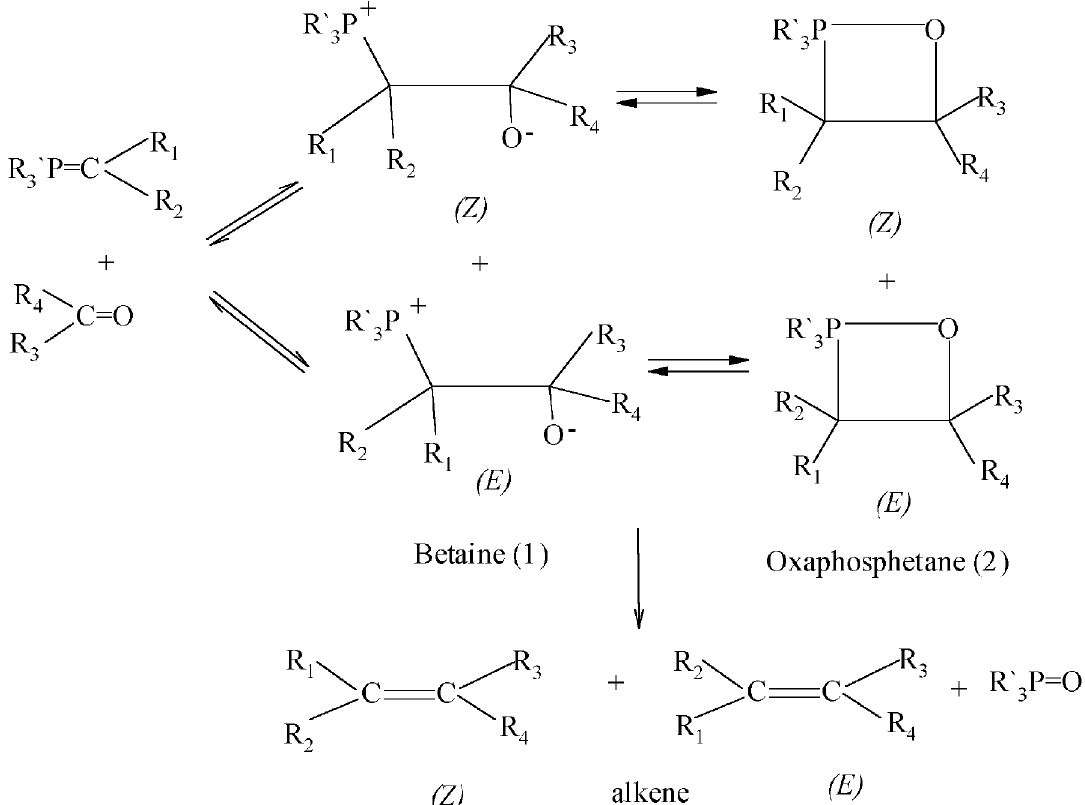
Scheme 2 The mechanism of the Wittig